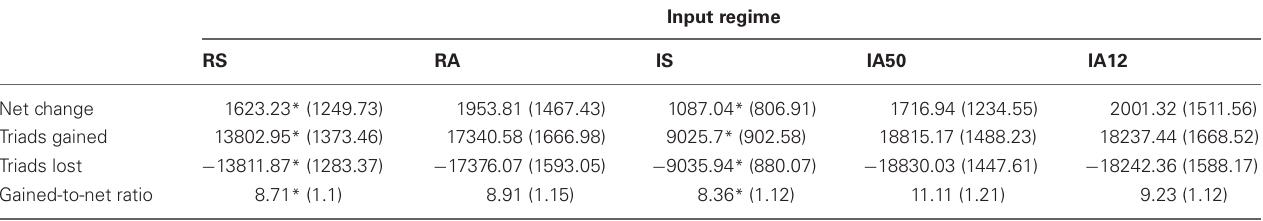
Values represent means across simulations. Values in parentheses represent SD’s across time. * Indicates significant difference in measure due to input regime.